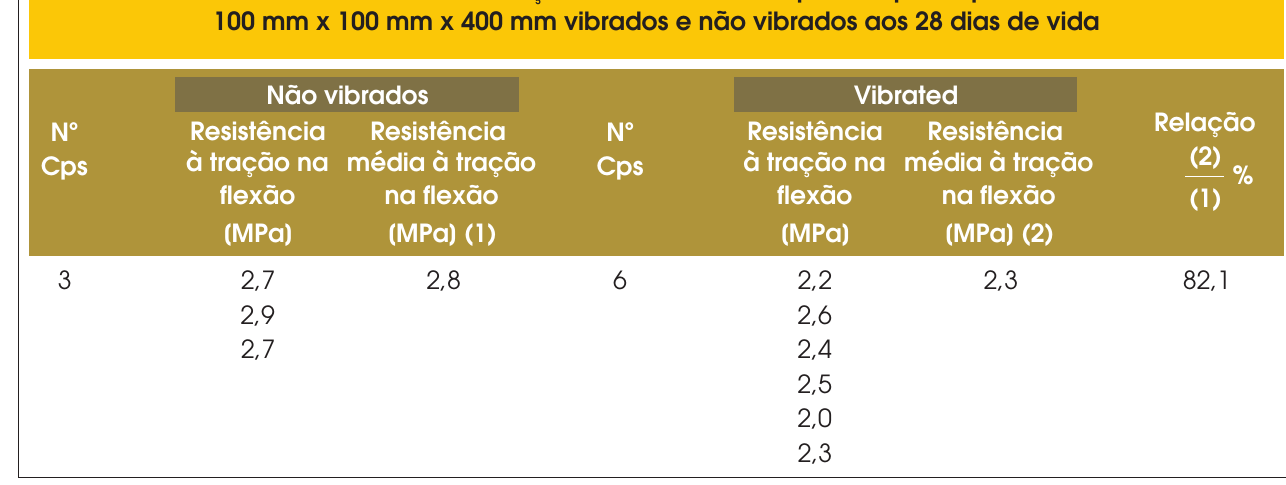
Tabela 7 – Resistência à tração na flexão dos corpos-de-prova